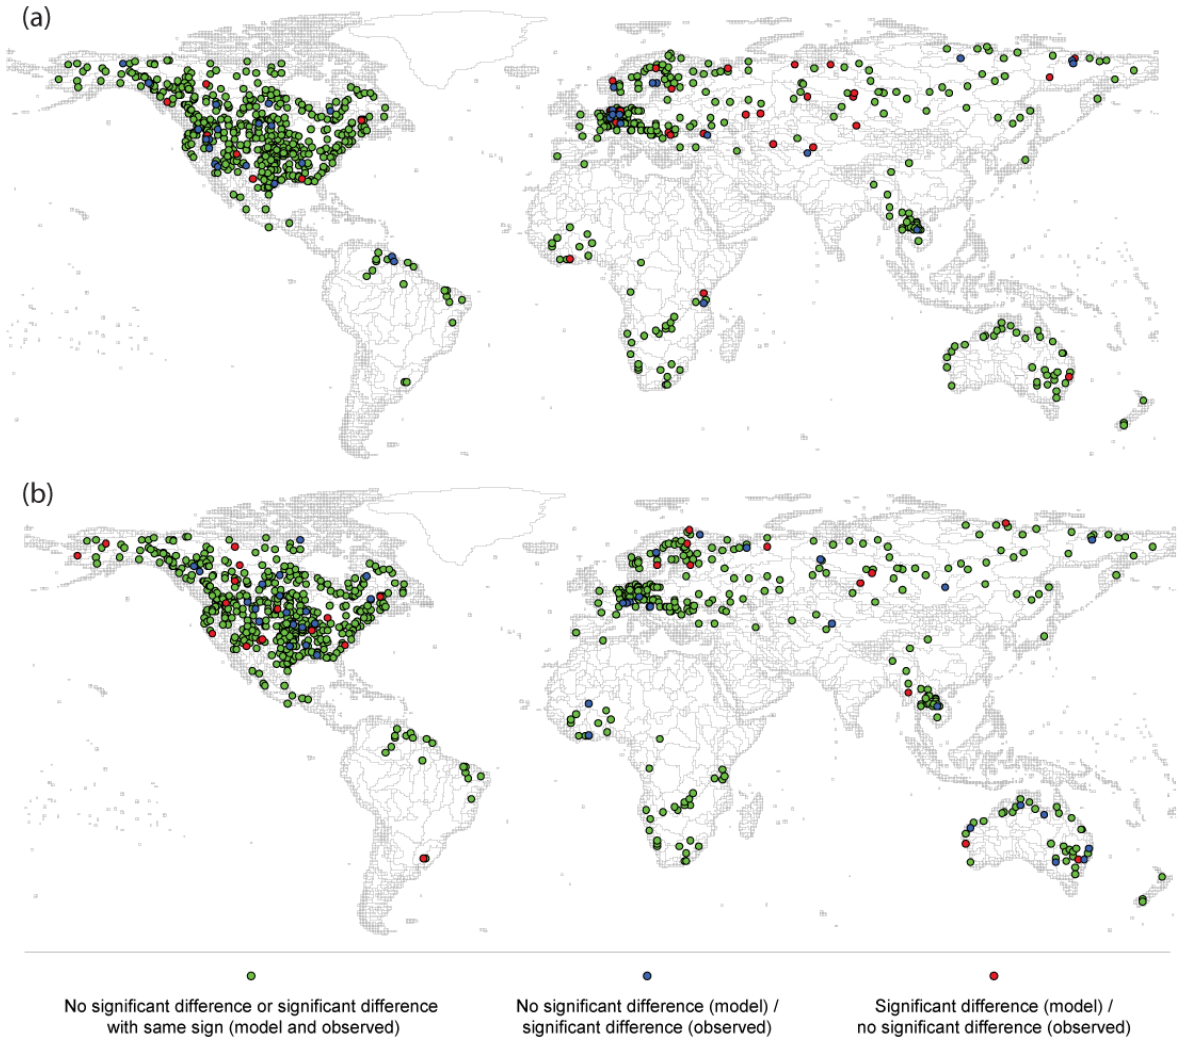
Fig. 3. Indicator of the agreement/disagreement between modelled and observed median Q max between (a) El Niño years and non-El Niño years, and (b) La Niña years and non-La Niña years. There are no stations for which modelled and observed median Q max show significant differences between El Niño and non-El Niño (or La Niña and non-La Niña years) years with the opposite sign. Statistical significance was assessed using a 2-tailed Mann–Whitney U (MWU) test; α = 0 .